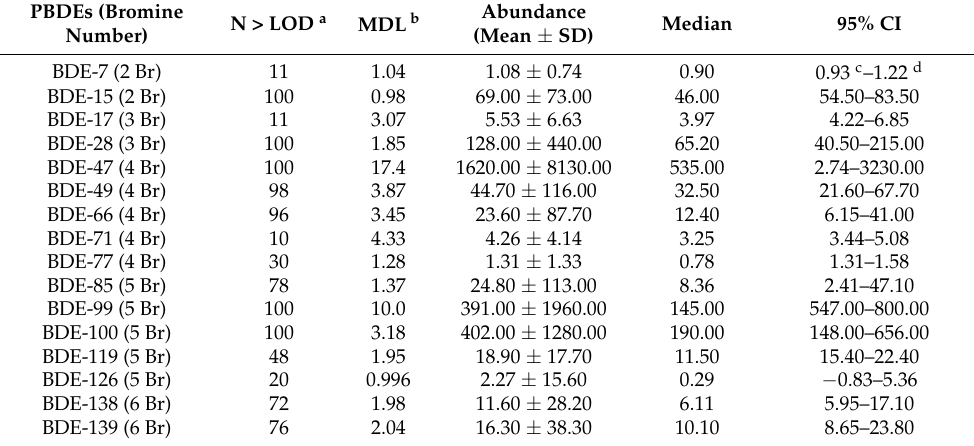
Table 2. Levels of 30 PBDE homologues in human breast milk of study participants from Kaohsiung and Pingtung areas of southern Taiwan (pg/g lipid) (n =